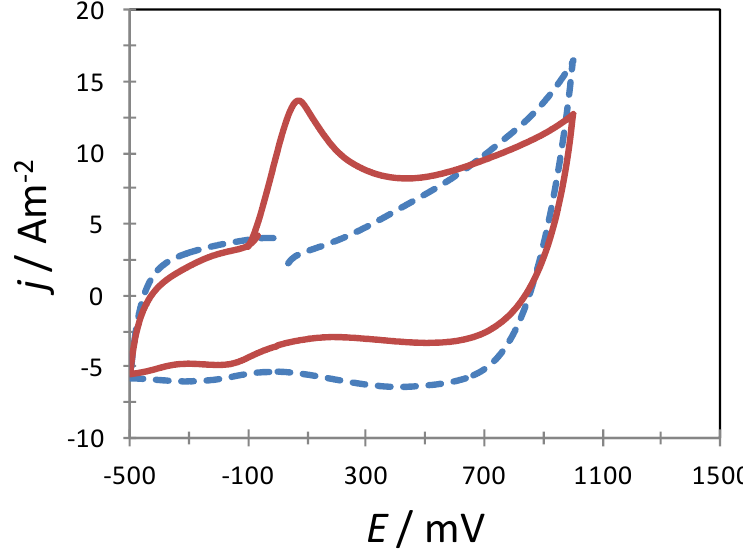
Figure 6. Experimental CVs recorded in the system CPE/poly- β -CD/0.1 M NaCl, at pH 3.0 (points) at 120 mV s − 1 scan rate. In one case (solid line) the CPE/poly- β -CD was previously immersed in 1 mM AA, 0.1 M NaCl, at pH 3.0 for 5 min. whereas in the other case (broken line) the electrode was not exposed to the AA solution.